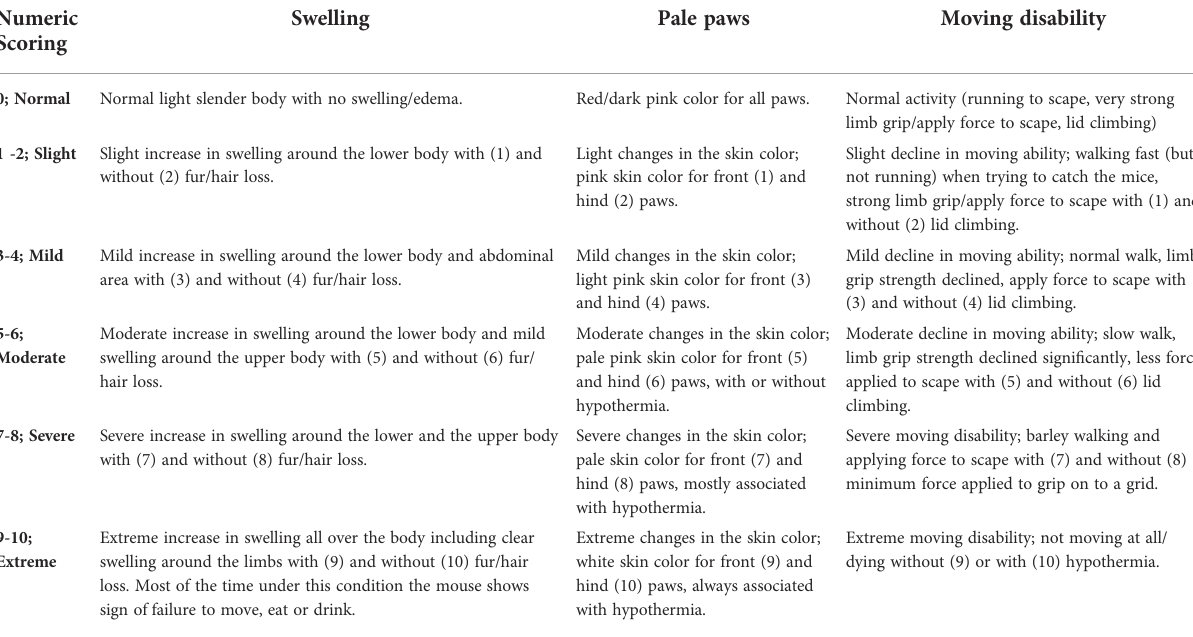
TABLE 1 Numeric scoring system for physical characteristics of NZW/LacJ x BXSB/MpJ F1 lupus-prone mouse model. Scoring System and Criteria for physical characteristics of lupus-prone mouse model Numeric Scoring